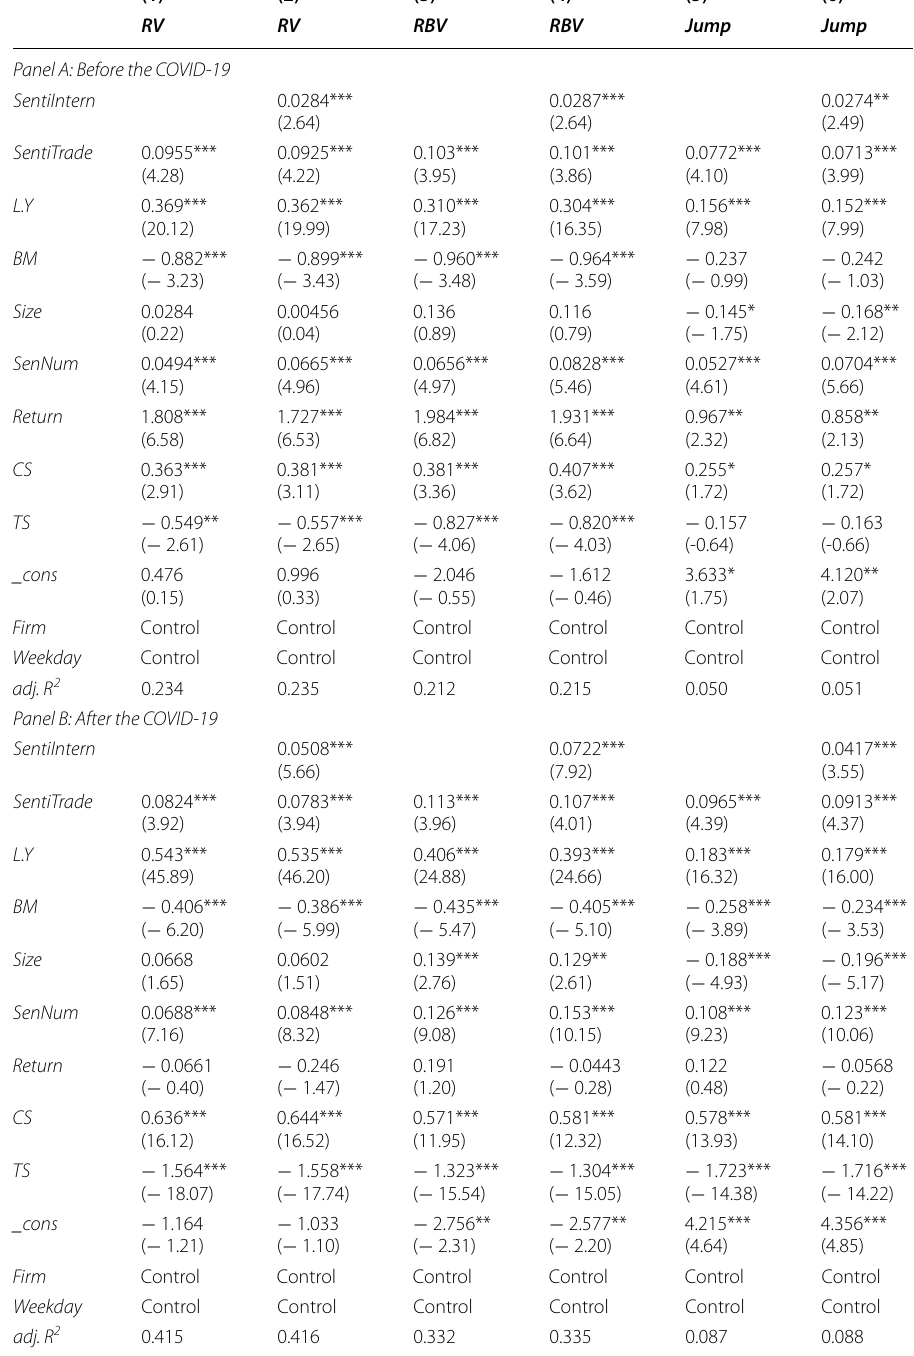
Table 9 Results of baseline model before and after the COVID-19